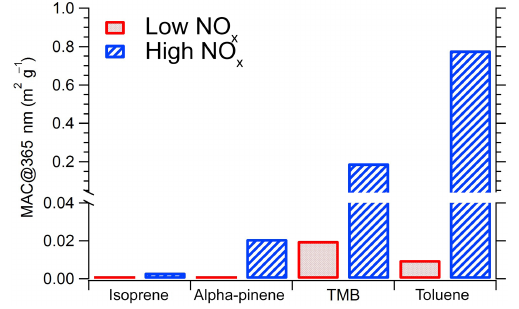
Figure 2. Comparison of MAC from various types of SOA, at a wavelength of